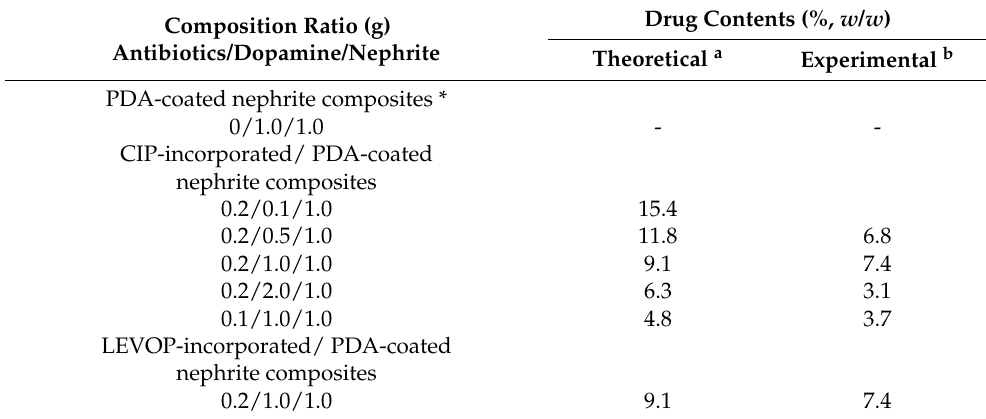
Drug Contents (%, w / w )